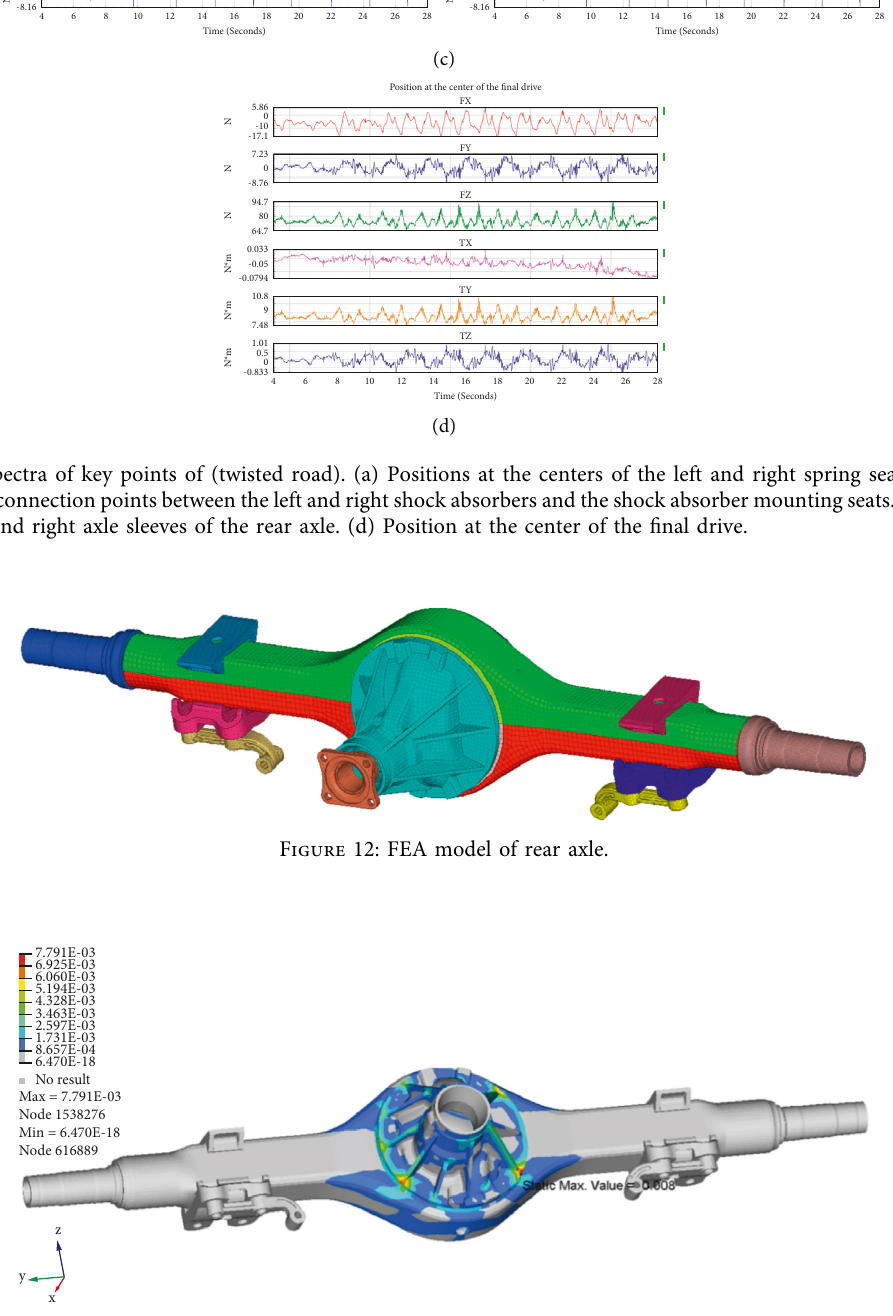
Figure 13: Stress contour of the rear axle when the unit load in the Y -direction acts on the center of the final